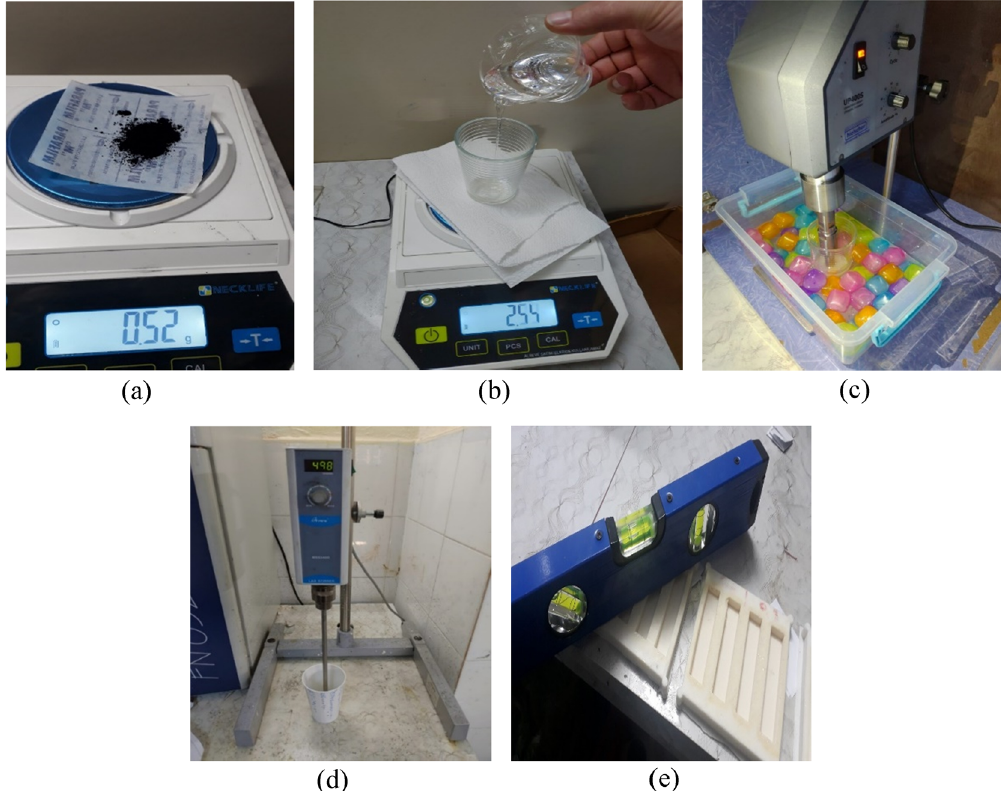
Figure 1: Preparation of samples: ( a ) digital scale, ( b ) addition of carbon black to epoxy resin, ( c ) ultrasonic mixer, ( d ) mechanic mixer, and ( e ) molds.